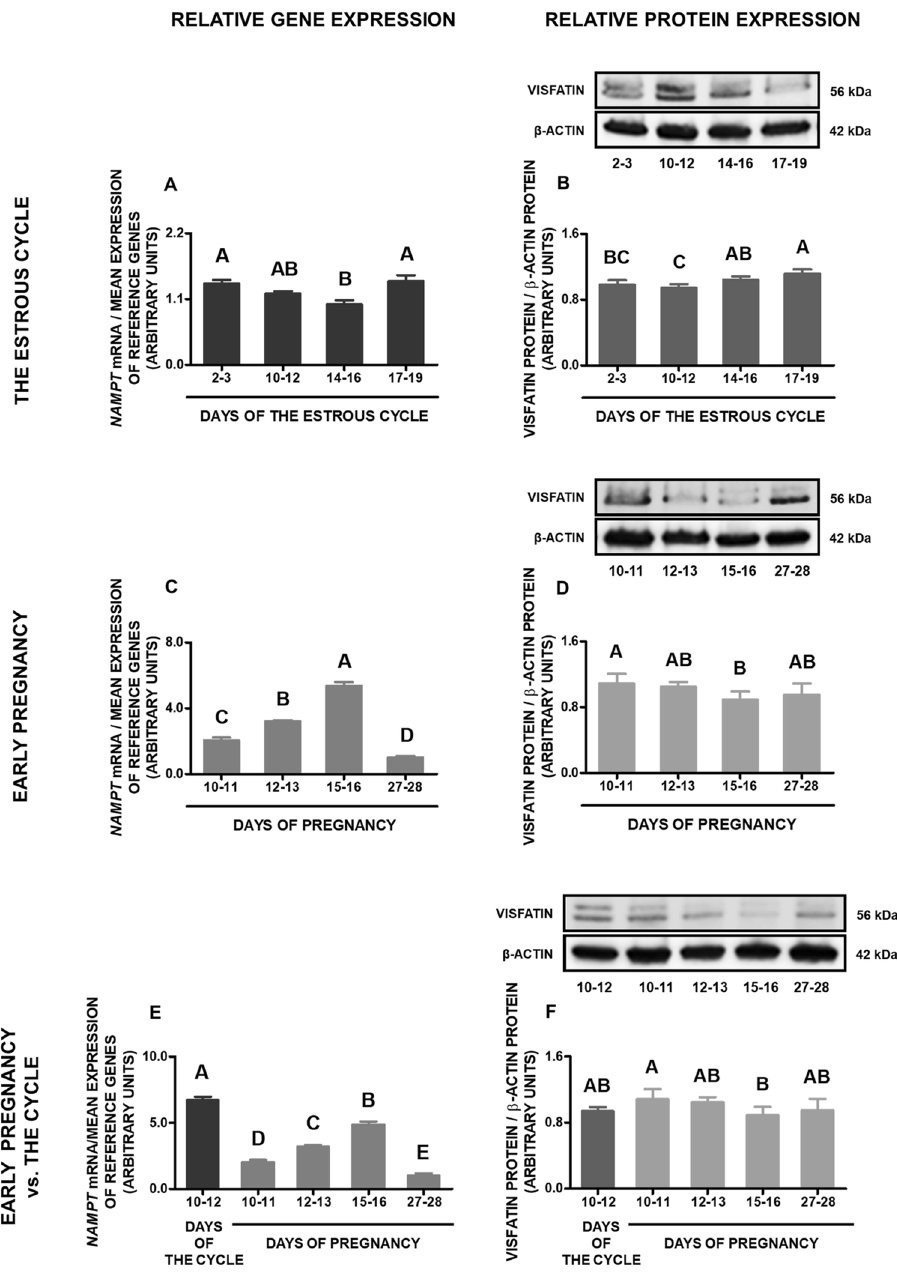
Figure 3. Visfatin gene and protein expression in the porcine mediobasal hypothalamus (MBH) during the estrous cycle and early pregnancy. Gene and protein expression of visfatin in the porcine MBH was determined during the estrous cycle on days: 2–3, 10–12, 14–16 and 17–19 ( A , B ), during early pregnancy on days: 10–11, 12–13, 15–16 and 27–28 ( C , D ) and compared between early pregnancy and days 10–12 of the estrous cycle ( E , F ). Gene expression was analyzed by qPCR. Protein expression was analyzed by Western blotting; upper panels: representative immunoblots; lower panels: densitometric analysis of visfatin protein relative to actin protein. Results are presented as means ± SEM (n = 5). Bars with different superscripts are significantly different (one-way ANOVA at p < 0.05 followed by Tuckey post hoc test at p < 0.05). Representative full length blots are attached as a Supplementary file